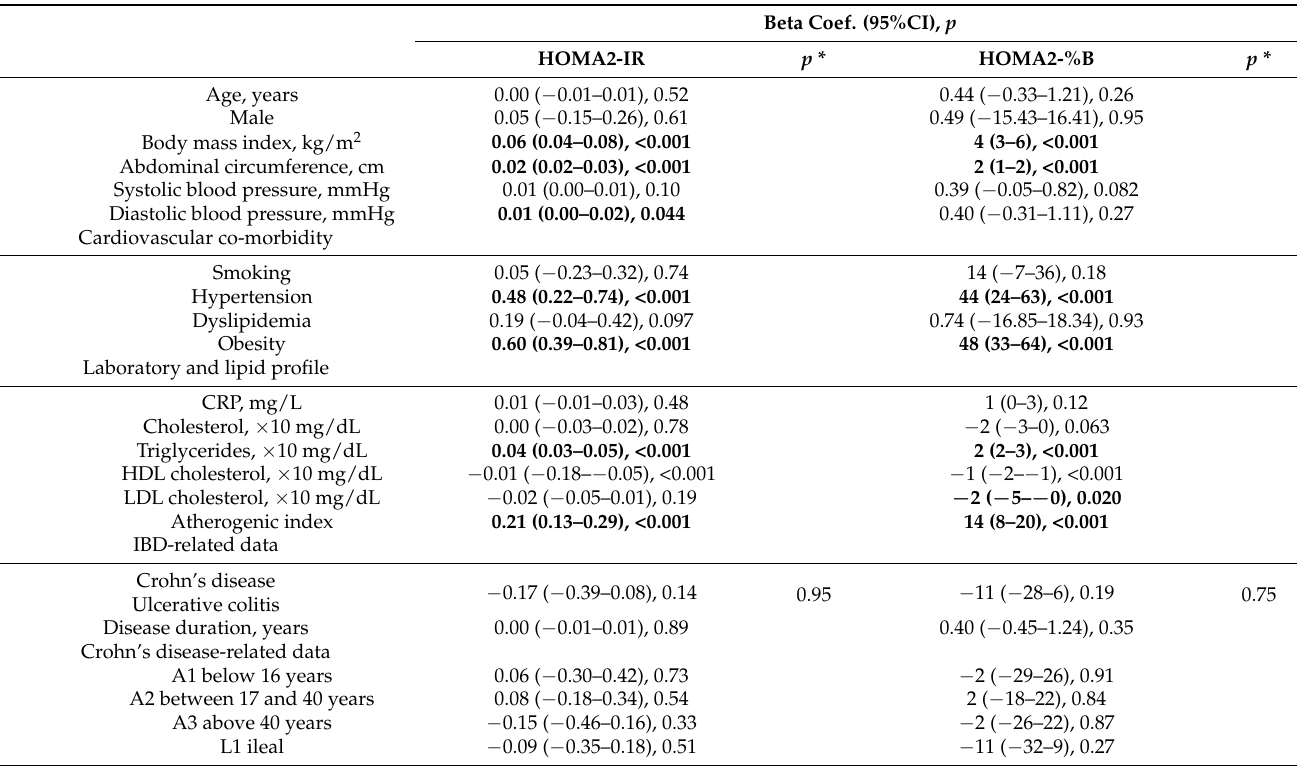
Table 3. Disease-related data association with insulin resistance and beta cell function indexes in IBD